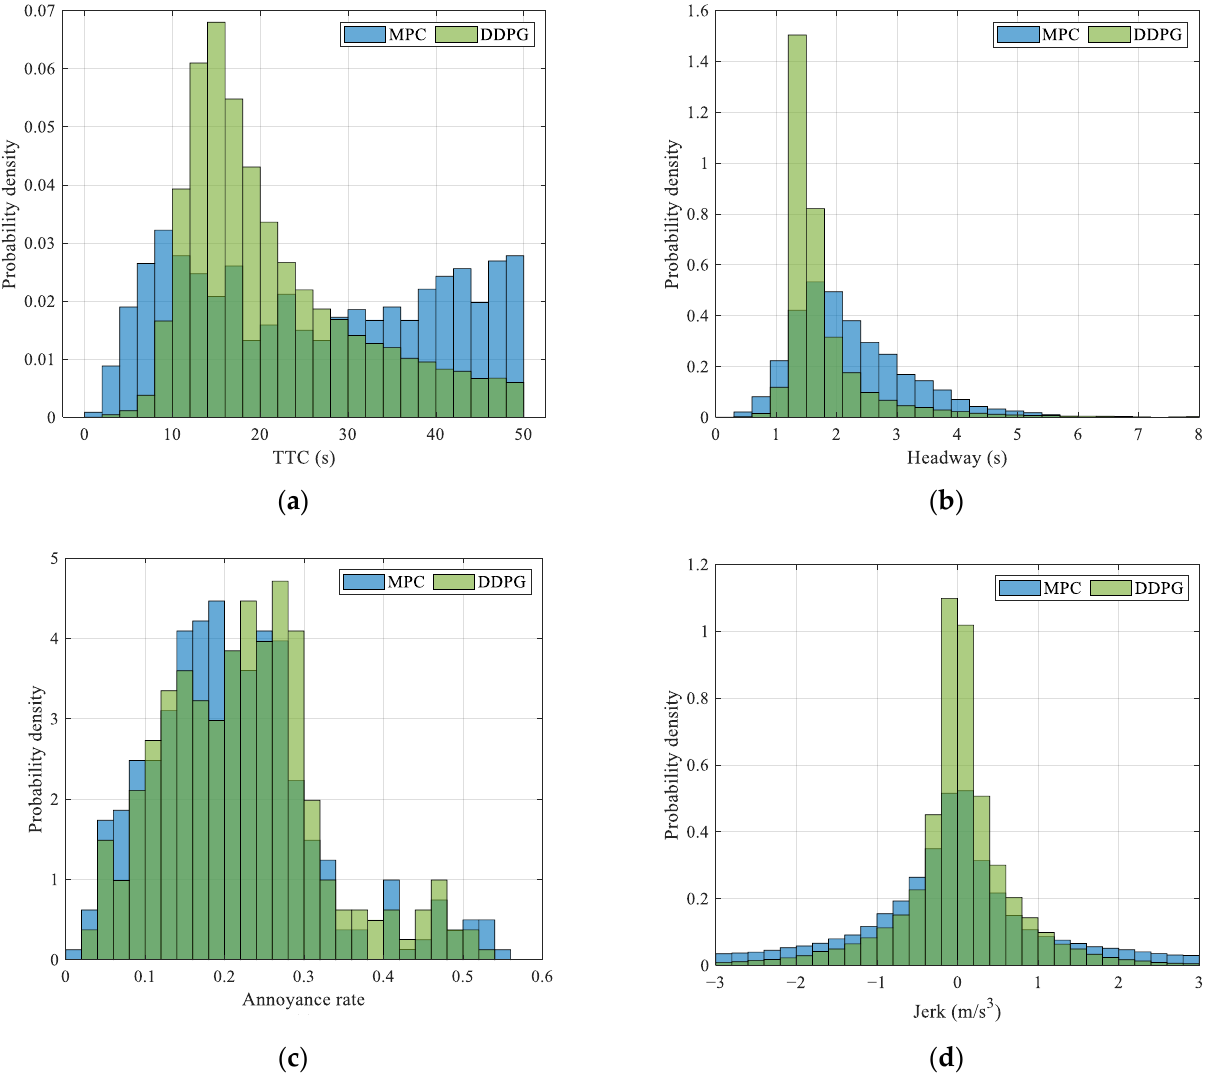
Figure 8. Probability density distribution of ( a ) TTC, ( b ) time headway, ( c ) annoyance rate, and ( d ) jerk.